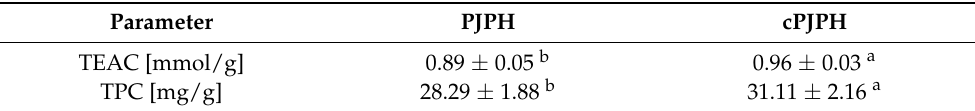
Table 4. Antioxidant activity was expressed as Trolox equivalent antioxidant capacity (TEAC), and total phenolic compounds (TPC).